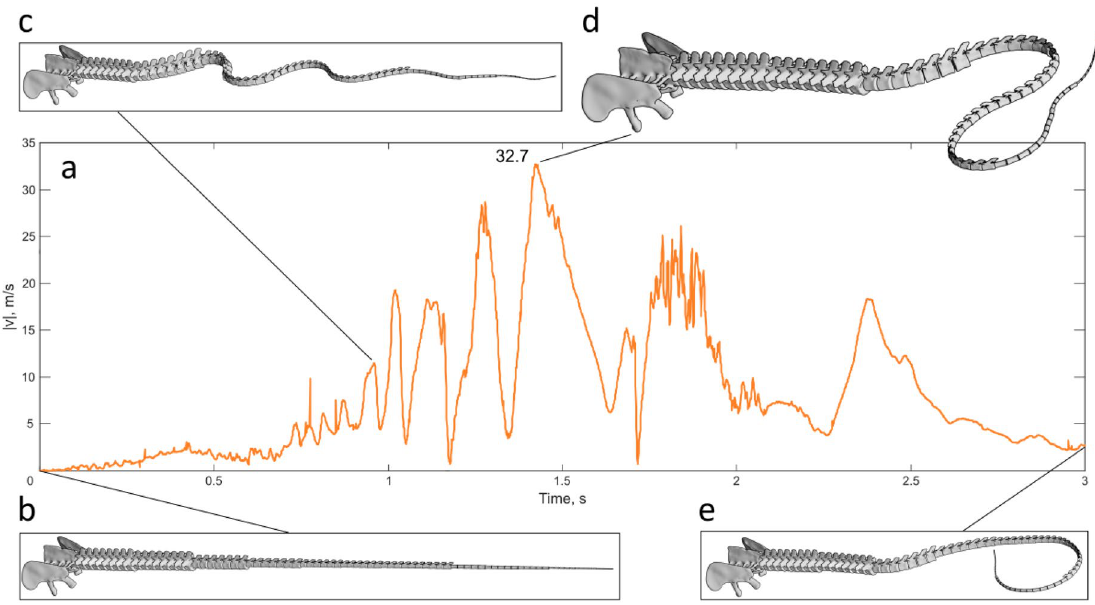
Figure 2. The velocity of the last vertebra during the simulation. ( a ) the velocity of the centrum of the last tail vertebra in m/s in the time of the simulation including the effects of air drags. ( b ) Position of the caudal centra at the beginning of the simulation, ( c ) position of the caudal centra at 1 s from the beginning of the simulation. ( d ) Position of the caudal centra at the moment the last centrum reaches the top speed (32.7 m/s). ( e ) Position of the caudal centra at the end of the simulation.